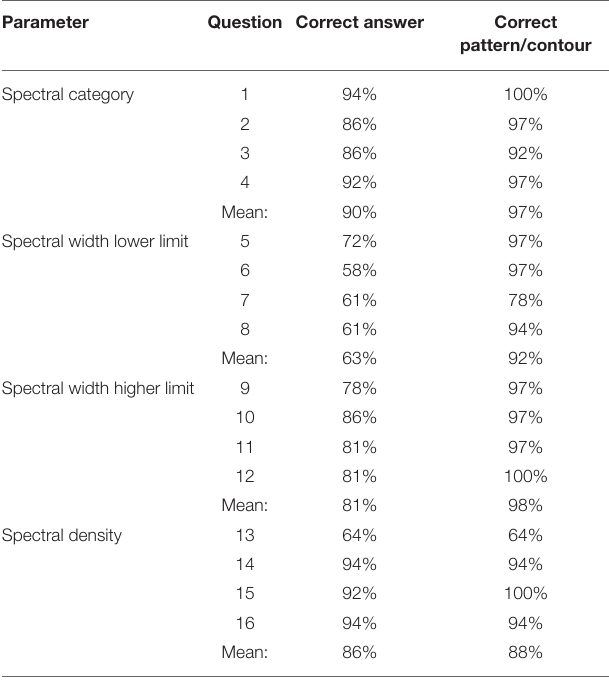
TABLE 1 | Table of results from the multiple choice notation